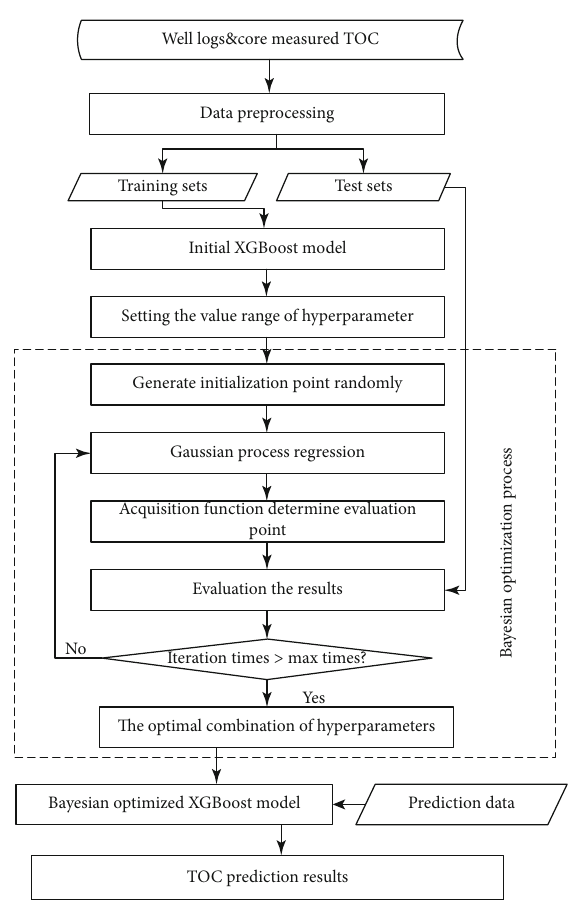
Figure 1: Flowchart of TOC prediction using the Bayesian optimization XGBoost